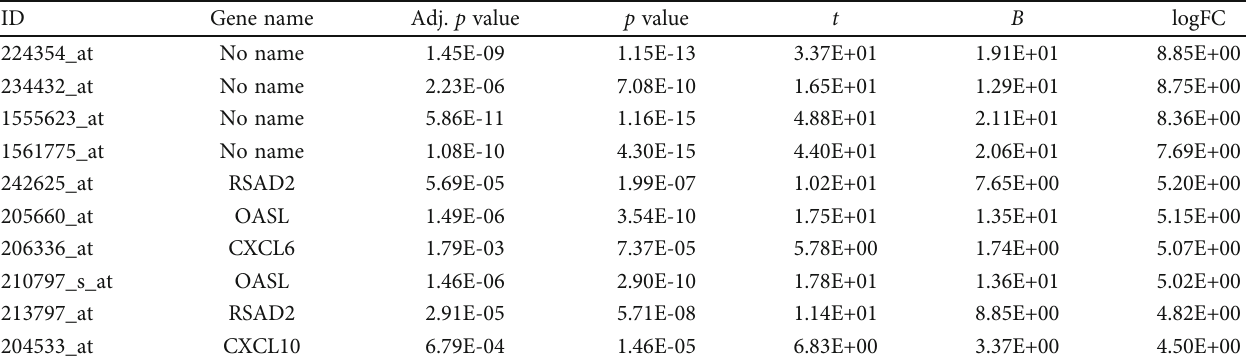
Table 1: Top ten upregulated DEGs in GSE61302 between undi ff erentiated human primary ADSCs and mature adipocytes. ID